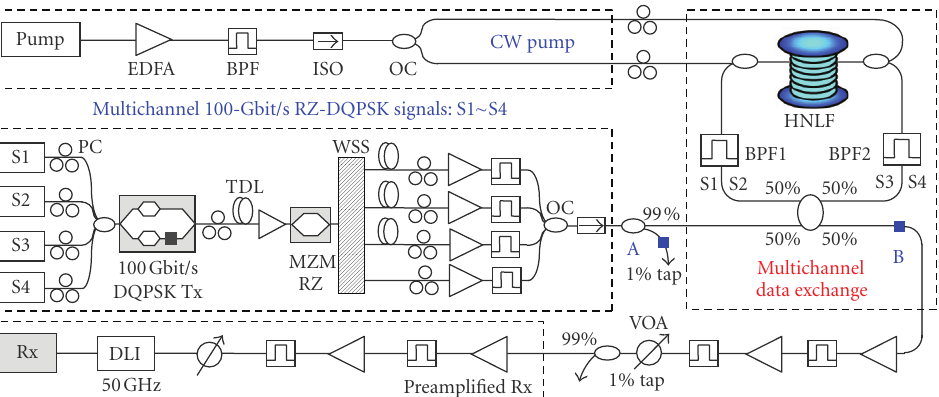
Figure 21: Experimental setup for multichannel DQPSK data exchange. HNLF: highly nonlinear fiber; BPF: band-pass filter; PC: polarization controller; EDFA: erbium-doped fiber amplifier; ISO: isolator; OC: optical coupler; TDL: tunable delay line; MZM: Mach- Zehnder modulator; WSS: wavelength-selective switch; VOA: variable optical attenuator; DLI: delay line interferometer; Tx: transmitter; Rx: receiver.